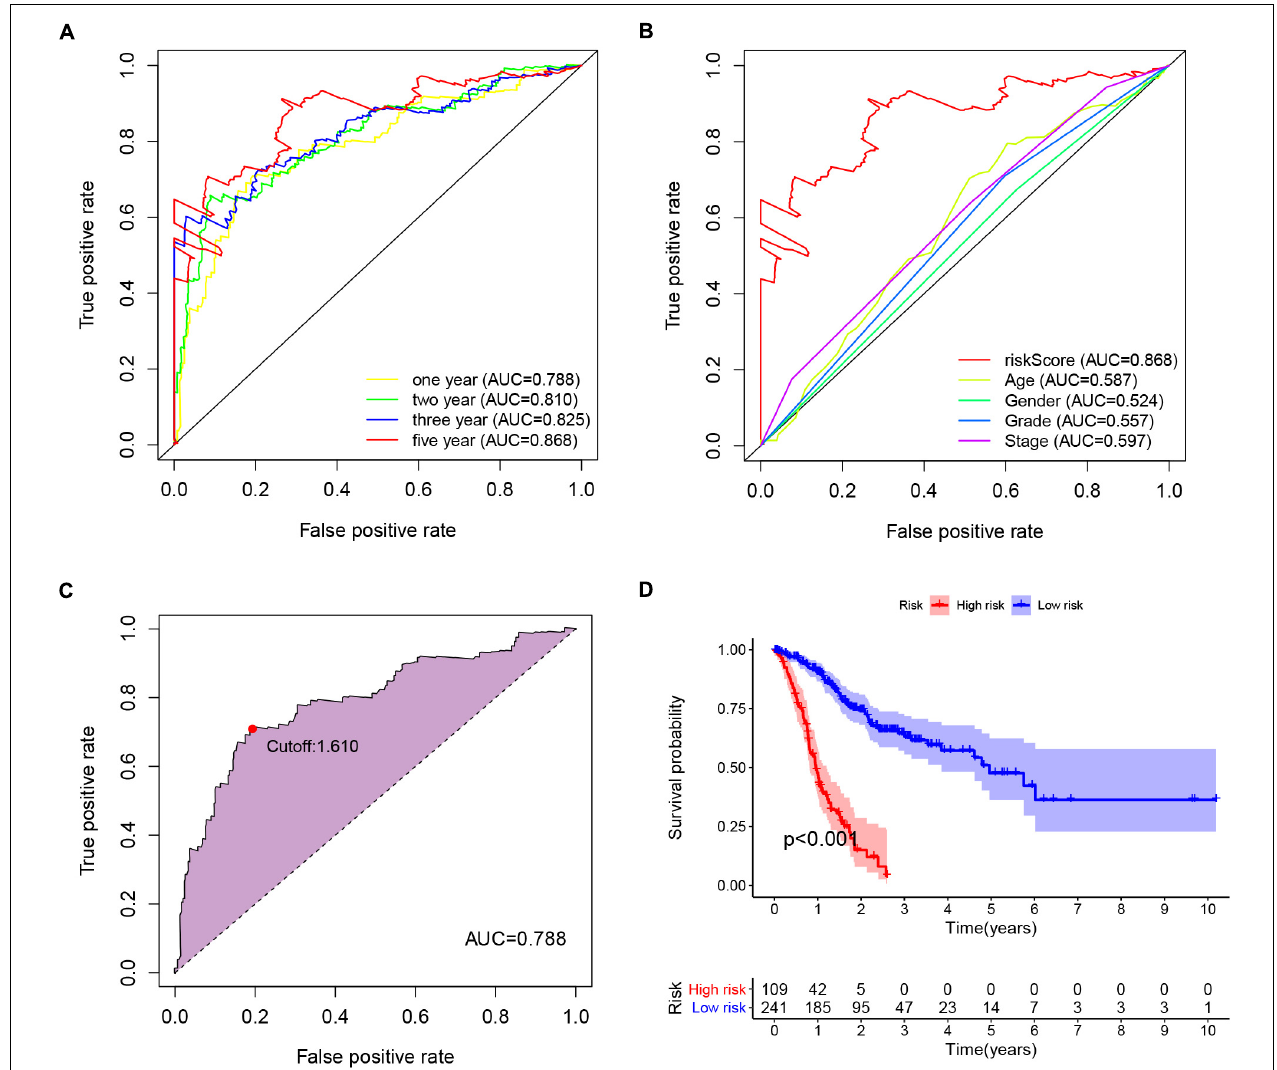
FIGURE 3 | Prognostic value of the IRlncRNAPs signature. (A) Time-dependent ROC curve analysis of riskScores and (B) the respective 5-year ROC curves of riskScores and other common clinical characteristics. (C) The cut-off point of the riskScore on the 1-year ROC curve was 1.610. (D) Kaplan–Meier survival curve analysis for the high- and low-risk group based on the